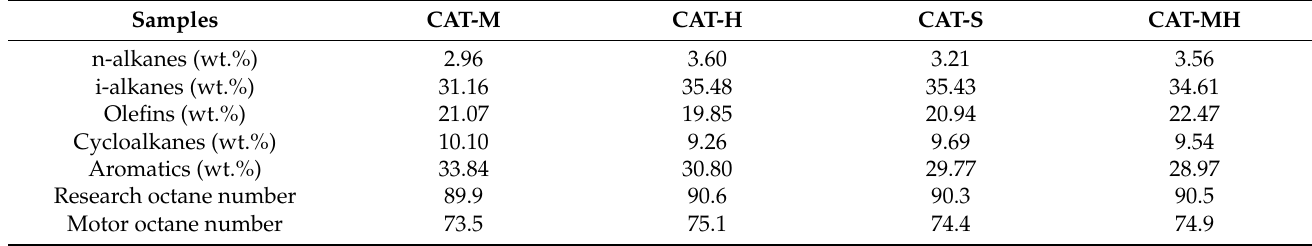
Table 8. The main properties of